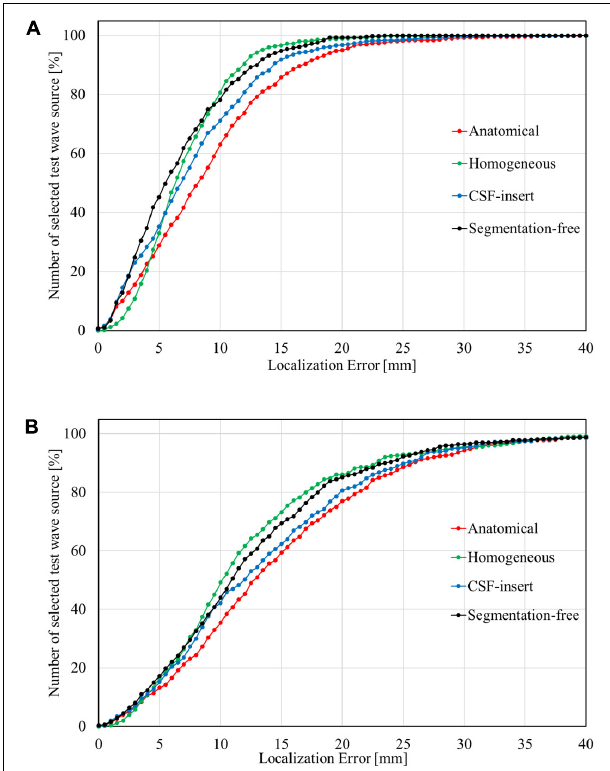
FIGURE 6 | Cumulative distribution of localization error with (A) 10–10 system and (B) 10–20 system in different head models for SNR = 5 dB. The bin size was 0.5